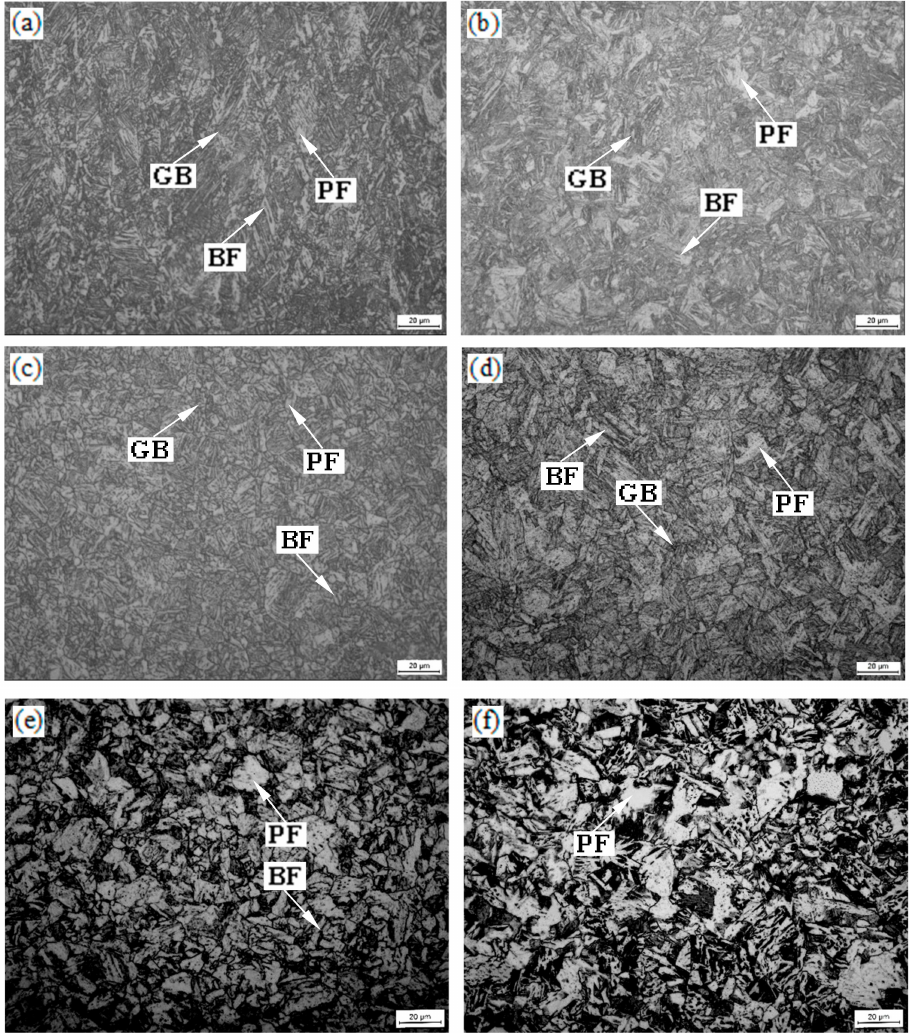
Figure 5. Optical micrographs of the experimental steel (by Nital etched) held at ( a ) 550 ◦ C; ( b ) 600 ◦ C; ( c ) 650 ◦ C; ( d ) 700 ◦ C; ( e ) 750 ◦ C; ( f ) 800 ◦